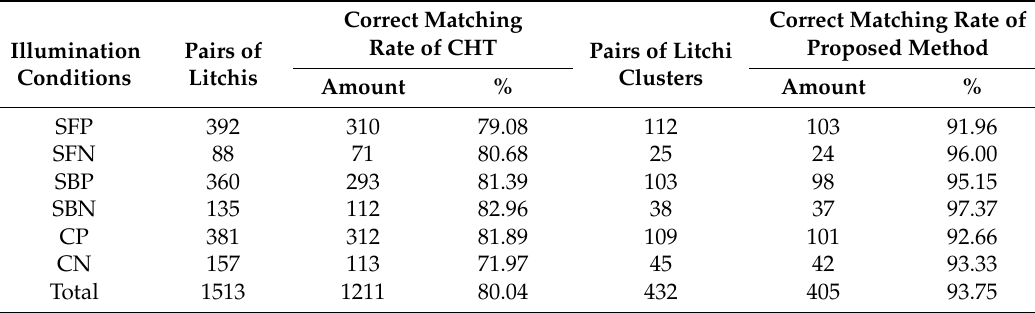
Table 2. The matching results of CHT and proposed